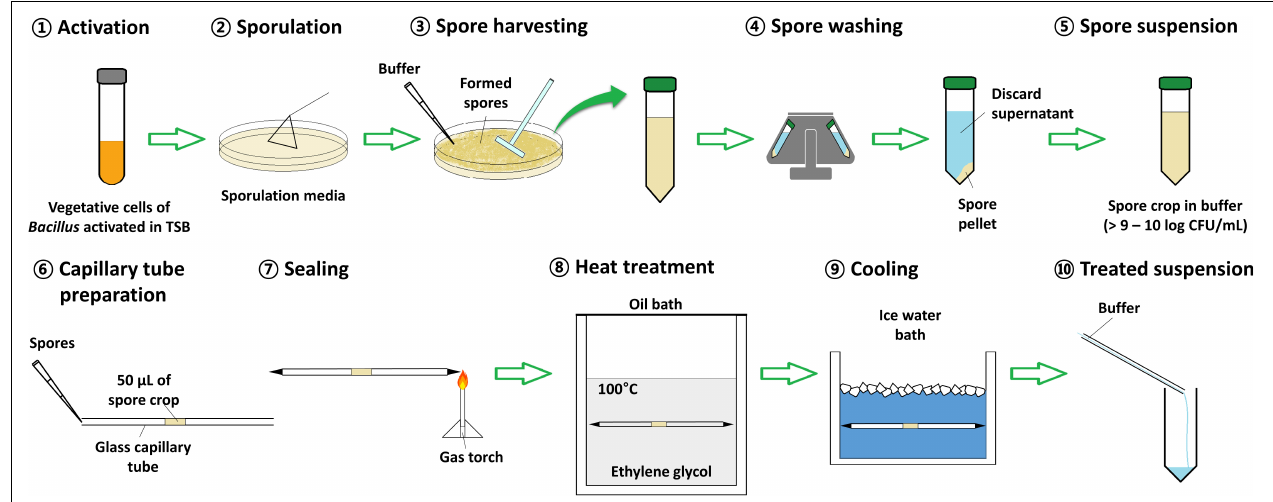
FIGURE 1 | Scheme of the procedure for spore formation and heat treatment. 1: A single colony of Bacillus spp. was activated in 5 mL of tryptic soy broth at 30 or 37 ◦ C for 24 h. 2: Twenty plates of each sporulation medium (nutrient agar supplemented with a selected combination of minerals) were inoculated with 100 µ L of Bacillus spp. culture and sporulated at 30 or 37 ◦ C for 48 h. 3: The formed spores were collected by pouring M/15 Sörensen’s phosphate buffer on the 20 agar plates, scraping the surfaces with a cell scraper, and transferred into a conical tube. 4: The spores were washed with the buffer by centrifuge at 10,000 × g for 10 min, 4 ◦ C, three times, intermittently discarding the supernatant. 5: The final spore crop was adjusted to a volume of 40 mL yielding a final spore concentration of > 9–10 log CFU/mL. 6: A 50 µ L aliquot of the spore crop was pipetting into the center of a glass capillary. 7: The capillary was sealed at both ends using a gas torch. 8: The loaded capillary was submerged in an oil bath set at 100 ◦ C. 9: At set time intervals, a capillary was removed and immediately placed in ice water to cool for 1 min. 10: The ends to the capillary were aseptically cut and the content was flushed into a conical tube using 3 mL of M/15 Sörensen’s phosphate buffer. The treated suspension was then serially diluted and plated on plate count